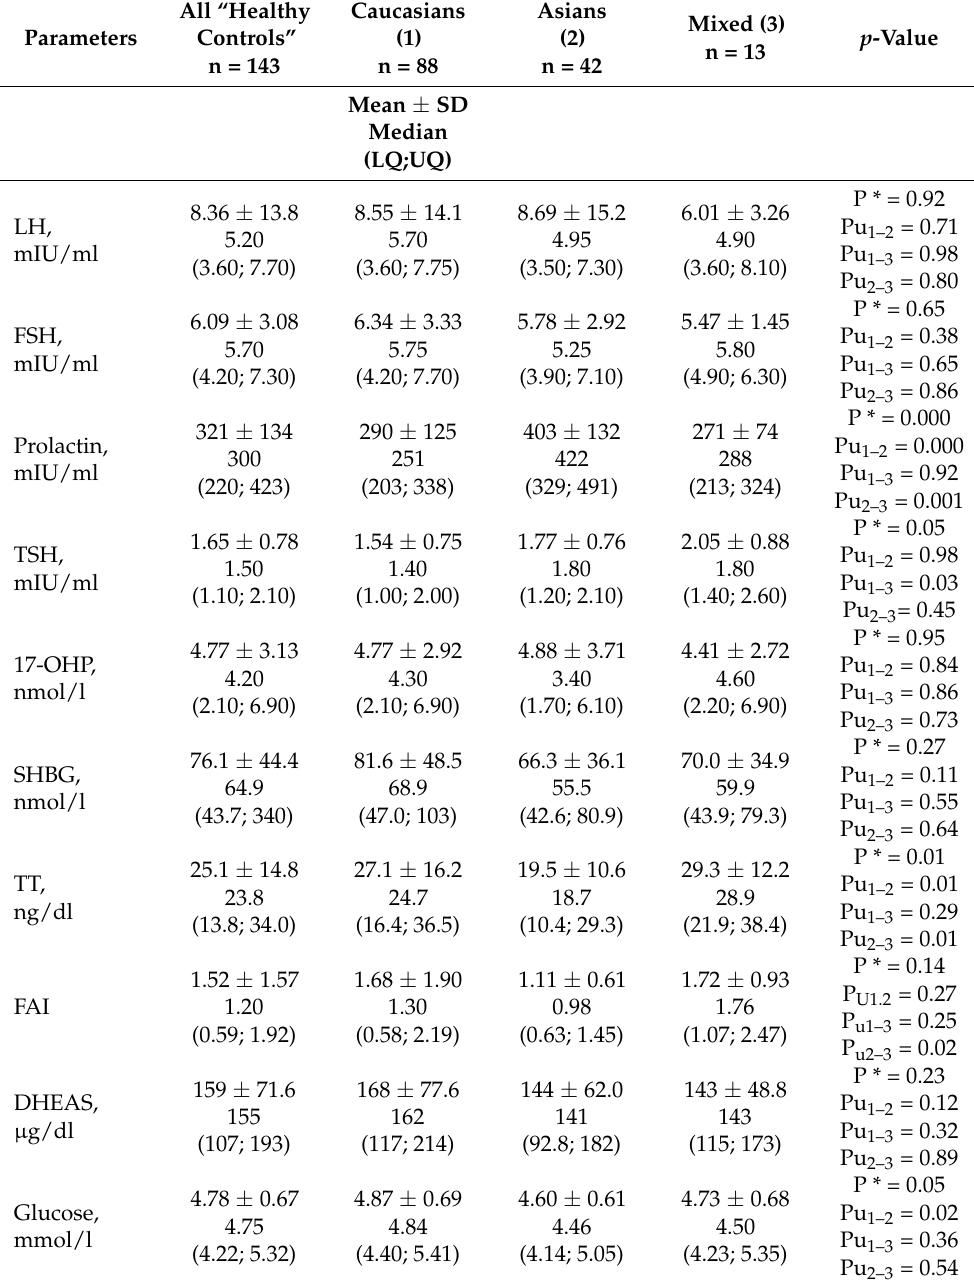
Table 4. Hormonal and glucose levels in women in the healthy control group, overall and by ethnicity.